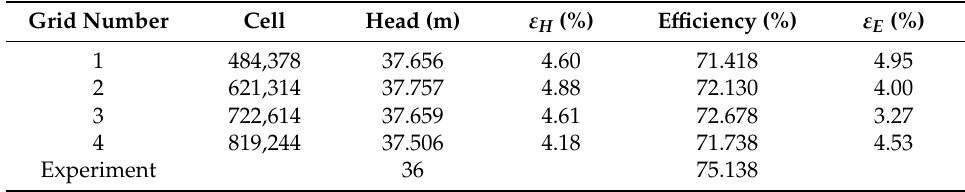
Table 4. Results from the mesh independence